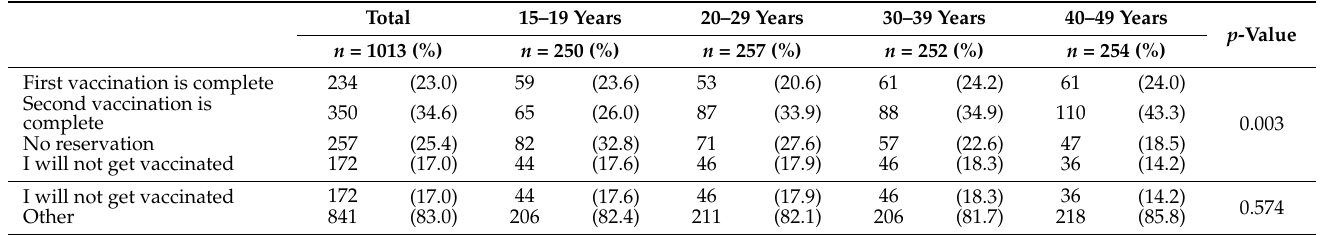
Table 1. Vaccination status and proportion of those who answered, “I will not get vaccinated in the first